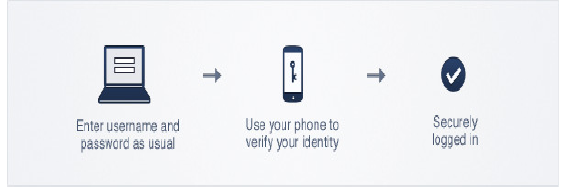
Figure 3: How a mobile security system